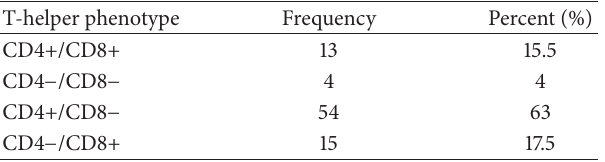
Table 3: T-helper phenotype in 86 Iranian patients.